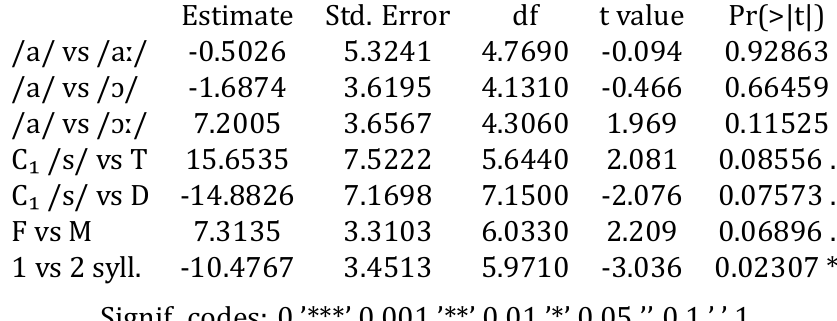
Table A.13: Post-aspiration duration (ms) of C₂ /s/ as a dependent variable